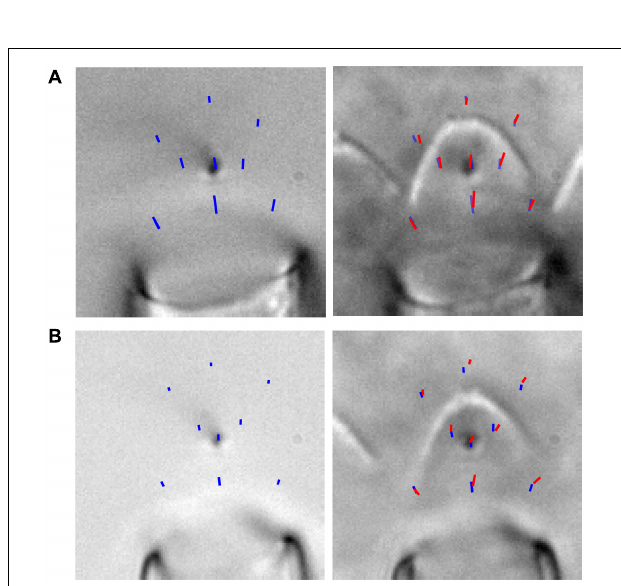
FIGURE 5 | (A,B) Two examples of fluid forces with (red) and without (blue) the hair bundle are shown. The images show the trajectories (from rest state to steady-state position) of a flexible fiber bent down toward the tissue such that it appeared as a point in x-y and a line in x-z . The fiber was moved to various positions, and the trajectory of four presentations of the largest stimulation at each position is overlaid on the image. This demonstrated that the hair bundle presence altered the flow, and the variability between stimulations of a given fiber position was very low. For experiments without the hair bundle, the fluid jet and flexible fiber were moved ∼ 200 µ m above the